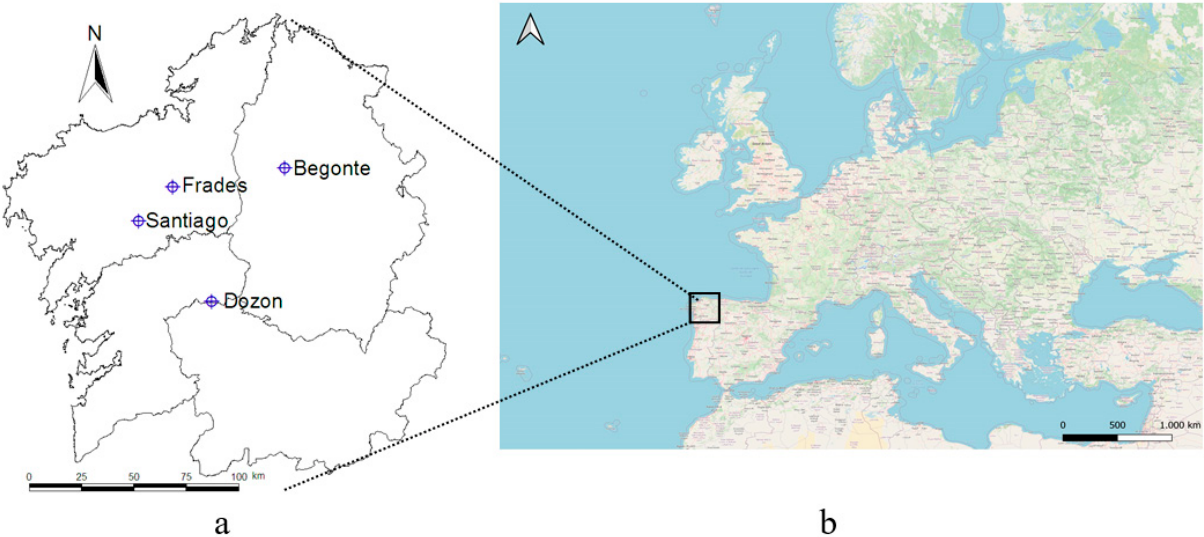
Figure 1. ( a ) Location of the four areas tested in Galicia. ( b ) General view of Galicia, Spain, and Europe.